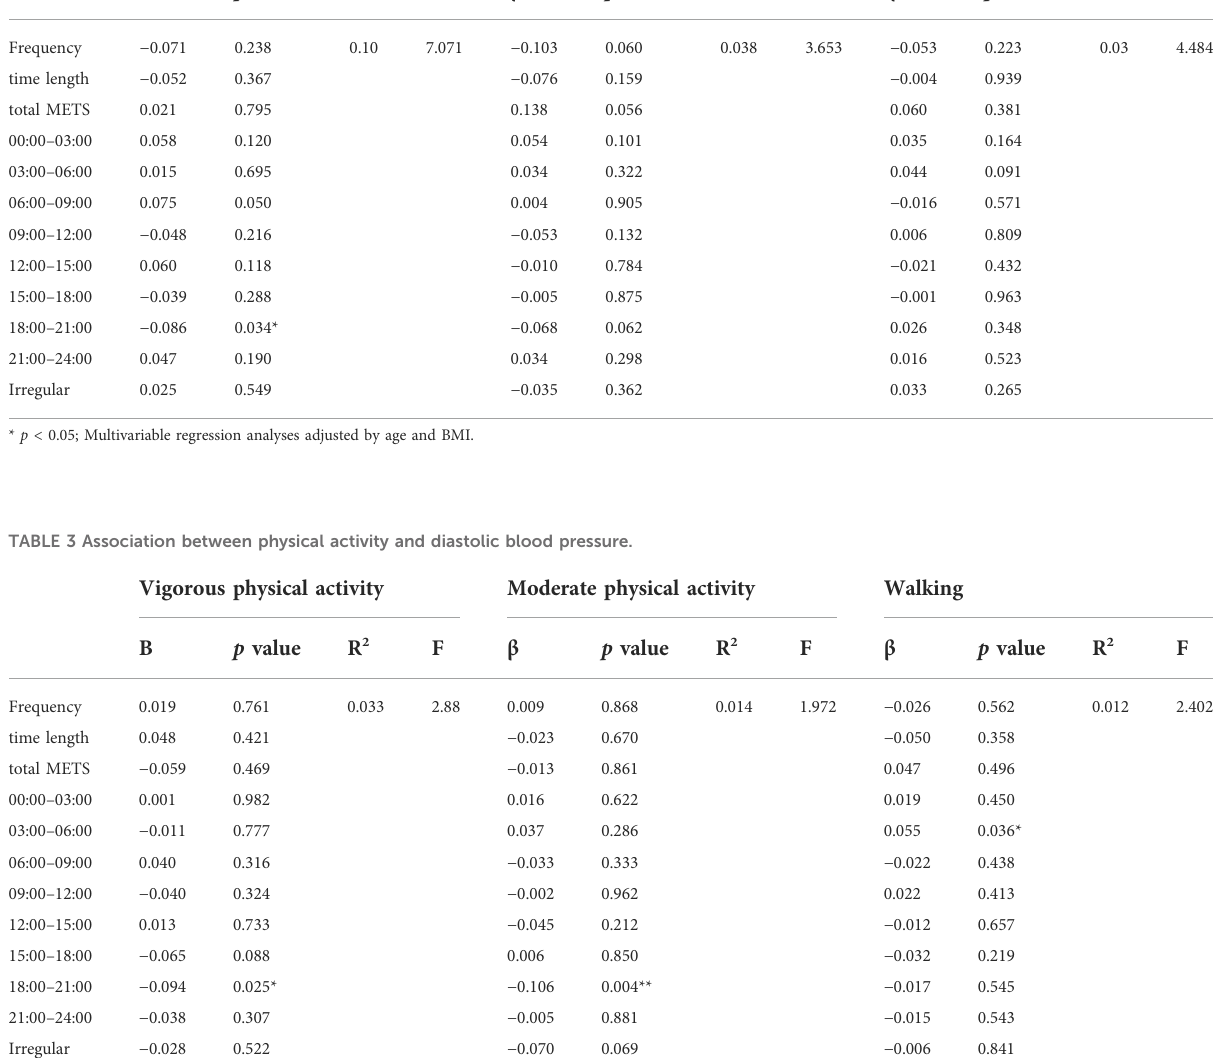
TABLE 2 Association between physical activity and systolic blood pressure. Vigorous physical activity Moderate physical activity